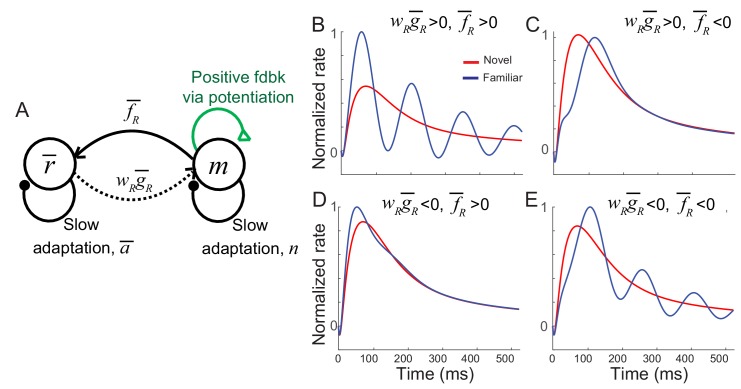
Networks with synaptic plasticity only in recurrent connections without the constraint of the sum normalization of synaptic weights achieved by ∑gk(ξj)=0.(A) Schematics of the mean-field dynamics after learning. The qualitative difference between the dynamics with or without the constraint is the feedback from r¯ to m (dotted curve). (B–E) Average response before (red) and after (blue) learning with different f¯R and wRg¯R. As the case with the constraint, the oscillation can be generated by the strong positive feedback and slow negative feedback in the m dynamics, and the synchronous oscillations in r¯ and m are determined by the signs of f¯R and wRg¯R. When f¯R and wRg¯R have the same signs, a positive feedback loop through r¯ further boosts the oscillation in the m dynamics (B,E), while the opposite signs of f¯R and wRg¯R suppress the oscillation (C,D). Synchrony oscillation between r¯ and m requires f¯R>0 (B,D), and wRg¯R>0 further increase overall oscillation as well as average rates (B). On the other hand, wRg¯R<0 diminishes the oscillation while decreasing average rates (D). None of these cases can reproduce the experimental observations, synchronous oscillations in r¯ and m with a decrease in the average rates. Thus, additional changes as the feedforward synaptic plasticity are still required without the constraint on the pre-synaptic dependence. The simulation of the mean-field dynamics is the same as in Figure 3—figure supplement 1 except wR = −0.1, a = −6.5, b = 5.5, t0 = 400 ms, t1 = 40 ms, f¯R=±0.1 and wRg¯R=±1.